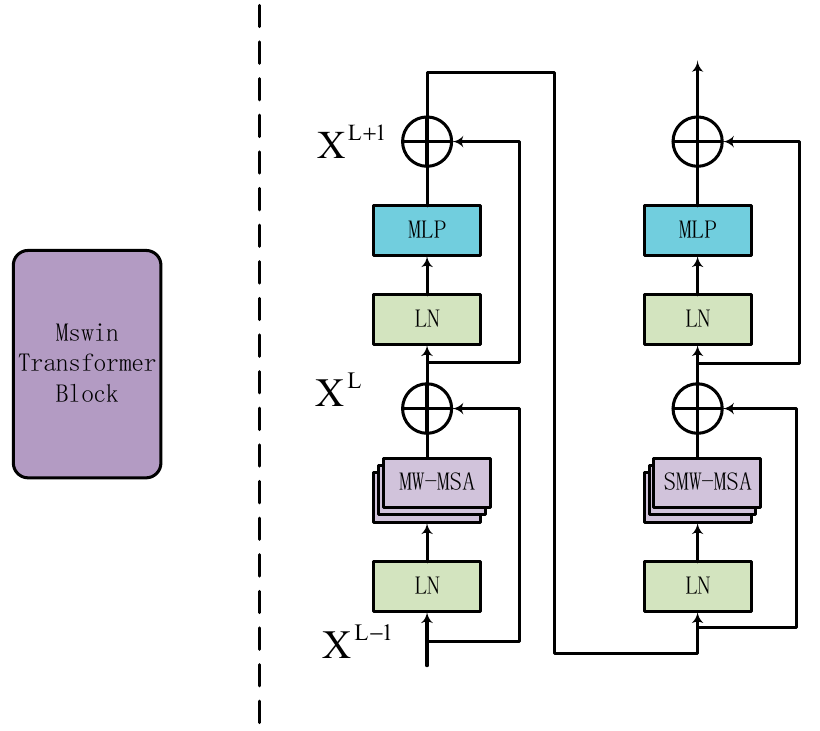
Figure 4. The Multi-Swin Transformer block is built by replacing the multi-head self-attention modules that have a regular (shift) window (W-MSA, SW-MSA) with a multi-scale (shift) window parallel module (MW-MSA, SMW-MSA). The LayerNorm (LN) and Multi-Layer Perceptron (MLP) are applied to the block.